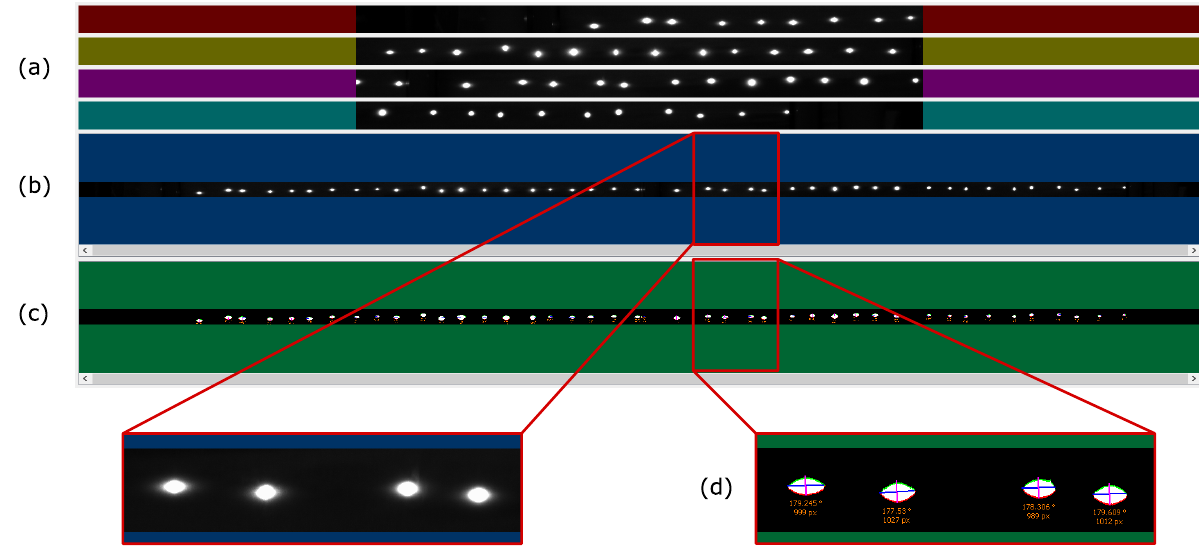
Figure 2. ( a ) Camera views to detect ellipses, ( b ) assembled view, ( c ) binarization step, ( d ) ellipse fitting.